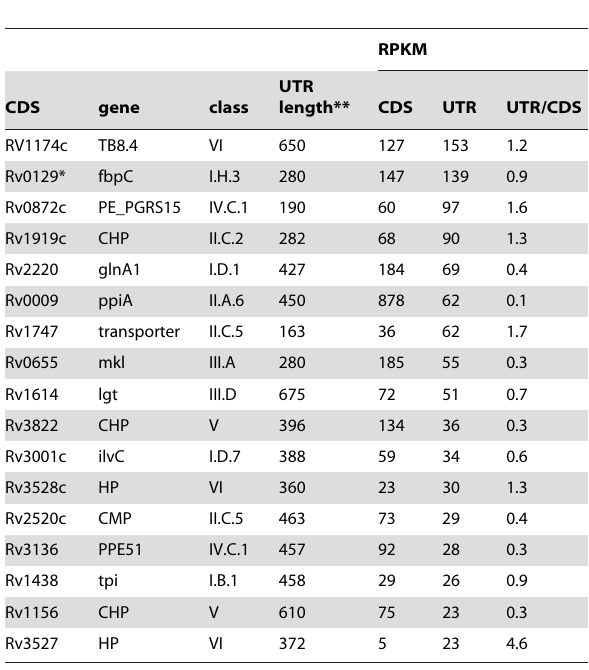
Table 9. Ranking of most abundant 3’ UTRs in intergenic regions in exponential